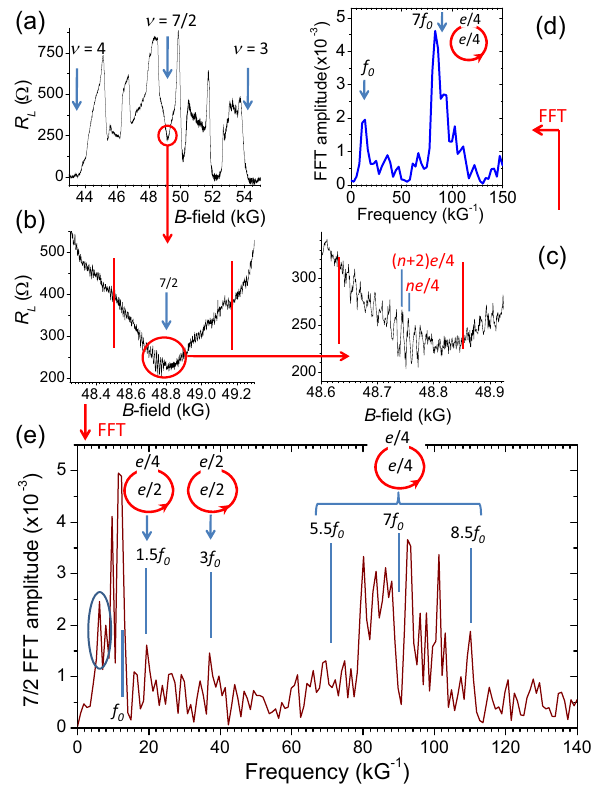
FIG. 7. Interference oscillations at ν ¼ 7 = 2 and their power spectra. (a) Transport between filling factors ν ¼ 3 and ν ¼ 4 . B Þ around the minimum at (b),(c) Successive enlargements of R L ð ν ¼ 7 = 2 , demonstrating sets of interference oscillations (sample 6, preparation 8, device type b, T ∼ 20 mK). (d) The Fourier spectrum of the sweep in panel (c) with the FFT window marked by the red vertical lines. f 0 marks the position of the FFT peak at ν ¼ 3 for this sample and preparation (see Fig. S5-1 in the Supplemental Material [34]). (e) A FFT using a larger range of B - field centered at ν ¼ 7 = 2 can potentially express the full comple- ment of e= 4 and e= 2 braids as shown for ν ¼ 5 = 2 in Fig. 11. The FFT window corresponding to ν ¼ 3 . 5 (cid:3) 0 . 03 is marked by red vertical lines in panel (b). The vertical lines marked 1 . 5 f 0 , 3 f 0 , 5 . 5 f 7 f 8 . 5 f 0 , 0 , and 0 are the respective multiples of f 0 identified at the integer filling, which correspond to expected features at ν ¼ 7 = 2 (see text for details). A broad spectral feature is centered at 7 f 0 , with a sharp minimum developing at that frequency. Additional ν ¼ 7 = 2 spectra are shown in Fig. 13(b) and in Sec. S5c of the Supplemental Material [34], all demonstrating a large spectral feature centered at their respective 7 f 0 frequen- cies, as expected for non-Abelian e= 4 at ν ¼ 7 = 2